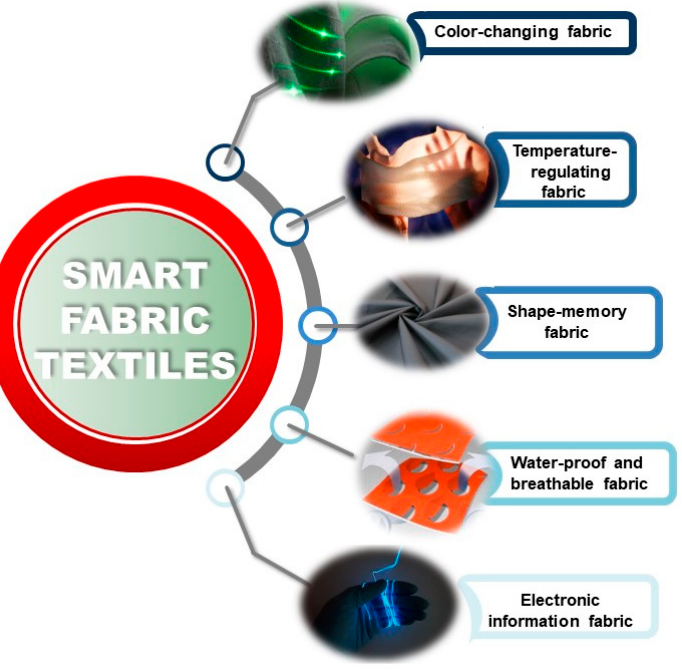
Figure 1. Several applications associate with smart fabric textiles. The images were taken from internet